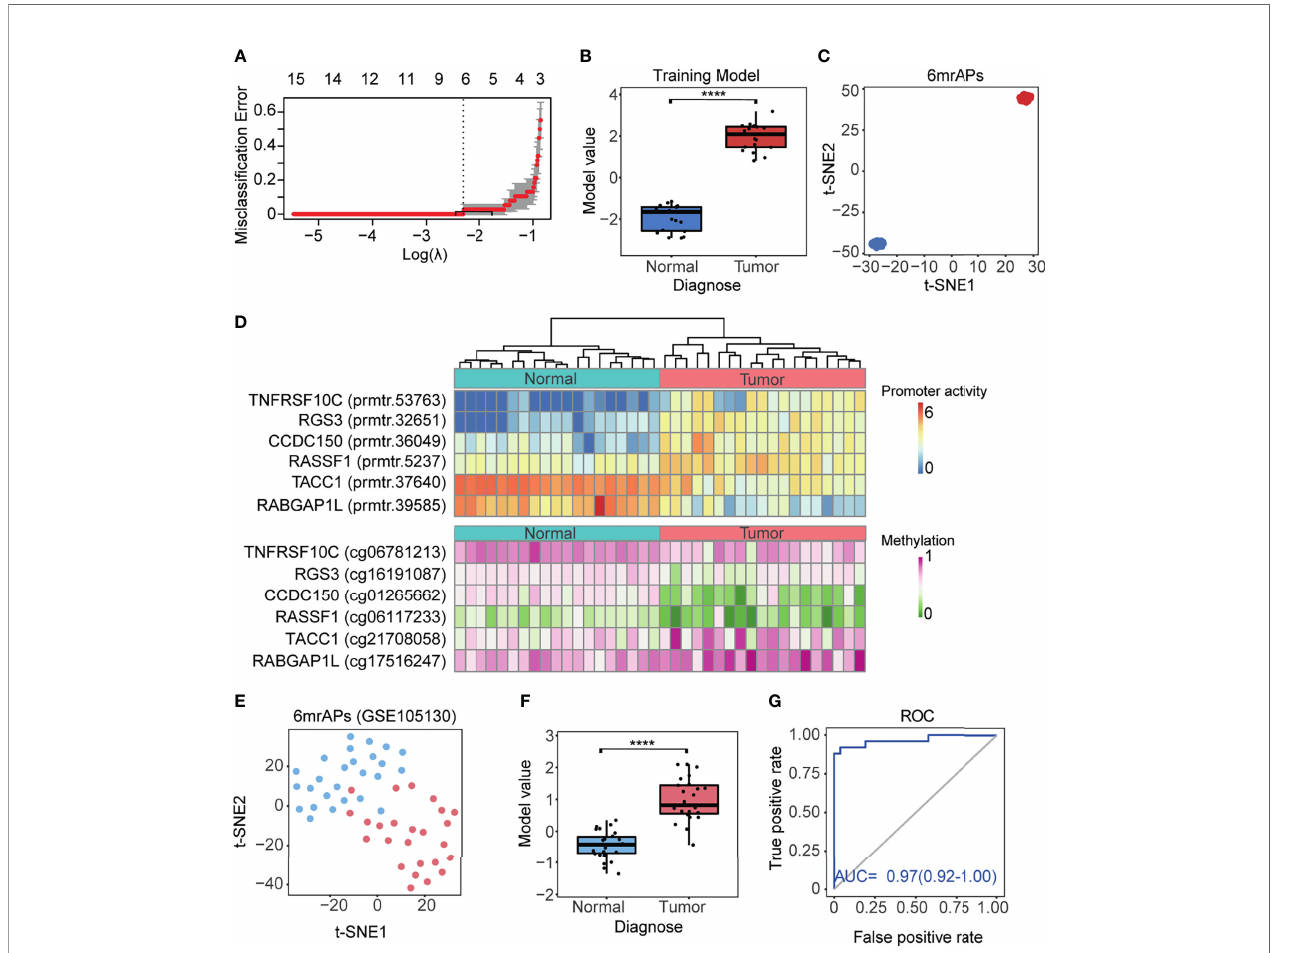
FIGURE 4 | A good performing HCC diagnosis model was generated using mrAPs. (A) The cross-validation fi t curve was calculated by the LASSO regression using promoter activities of all mrAPs, and six mrAPs were fi ltered to generate a diagnostic model. (B) The boxplot showing the signi fi cant different model scores of 19 paired tumors and normal samples based on the diagnostic model of 6mrAPs. **** p -value <0.0001 (Wilcoxon test, p -value = 5.7e-11) (C) t-SNE plot showing normal (blue dots) and HCC (red dots) samples can be signi fi cantly distinguished by the promoter activities of six mrAPs. (D) The upper heatmap showing the promoter activities of six mrAPs, the lower heatmap showing the screened CpG methylation status of six mrAPs. Samples are arranged in consistent order in both diagrams. (E) t-SNE plot showing normal (blue dots) and HCC (red dots) samples could also be grouped by the activities of six mrAPs in the independent test dataset of GSE105130. (F) Boxplot showing the signi fi cantly different model scores of HCC and normal sample of the test dataset of GSE105130. **** p -value <0.0001 (Wilcoxon test, p -value = 2.8e-11) (G) ROC curve showing the performance and prediction accuracy of the diagnostic model in the test dataset of